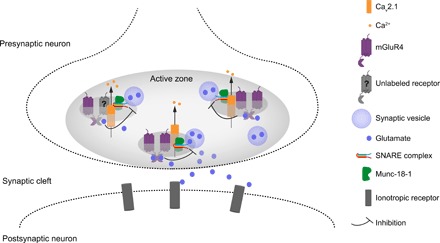
Schematic representation of mGluR4 nanoscale organization within the AZ.Our data reveal a high level of spatial organization at parallel fiber AZs, where we find mGluR4 in close proximity to CaV2.1 channels and Munc-18-1. This places mGluR4 right next to both the channels implicated in calcium influx (CaV2.1) and a key regulator of the SNARE complex (Munc-18-1), which, upon calcium entry, is responsible for the fusion of synaptic vesicles and the resulting release of neurotransmitters. These findings provide an ultrastructural basis to understand the mechanisms implicated in the regulation of synaptic transmission by mGluR4 and possibly other presynaptic GPCRs.